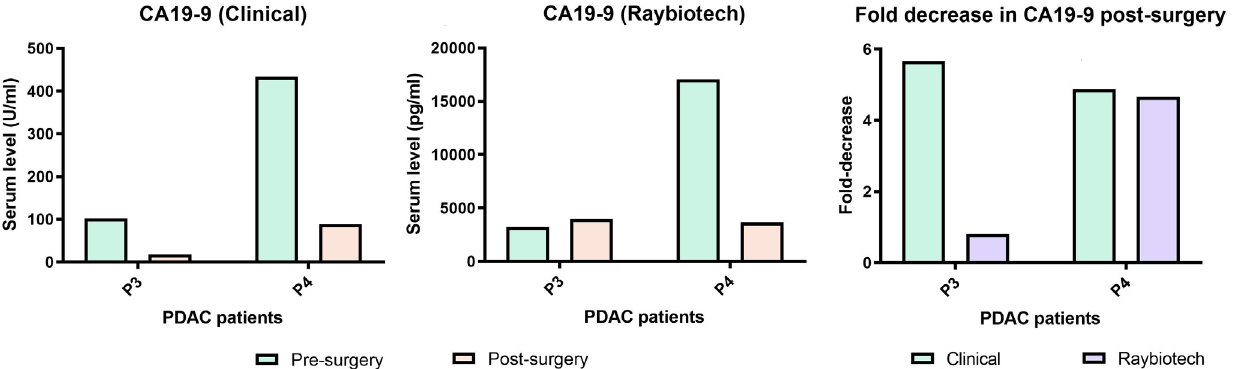
Figure 2. Comparison of CA 19-9 values obtained by clinical assessment versus Quantibody® array. ( A ) Clinical value of CA 19-9 before and after surgery in two PDAC patients. ( B ) CA 19-9 values obtained from the Quantibody® multiplexed array (Raybiotech) in the same patients. ( C ) The fold decrease seen in the two PDAC patients according to clinical and multiplexed